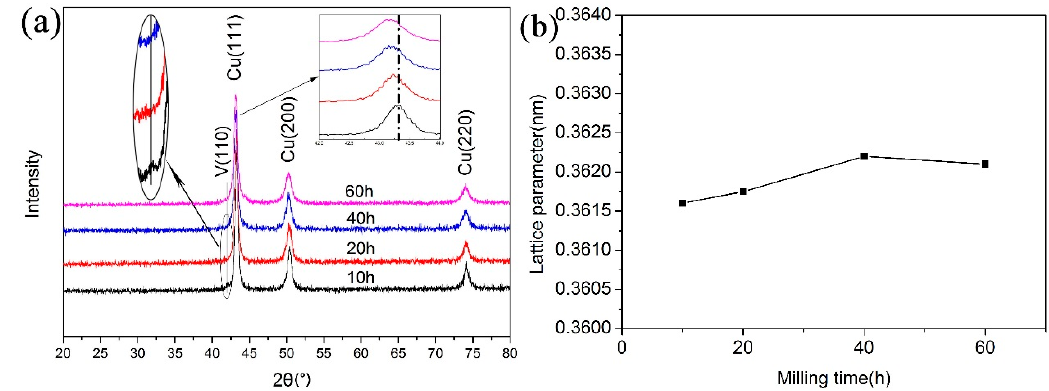
Figure 2. X-ray diffraction (XRD) patterns of Cu–V composite powder ( a ) and the lattice parameter of copper at different milling time ( b ).